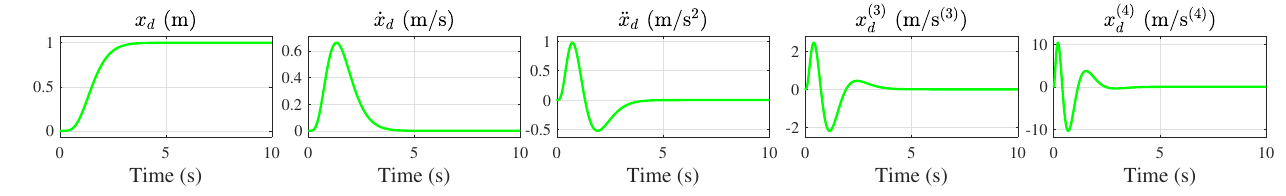
Figure 2. Desired output x d to its fourth differentiation. Table 2. System